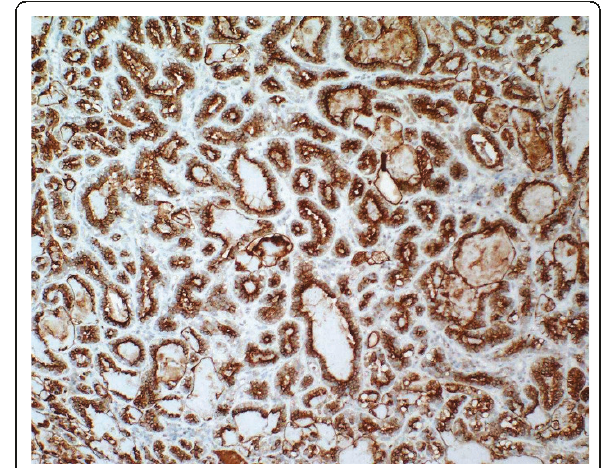
Figure 3 The epithelial component is positive for keratin